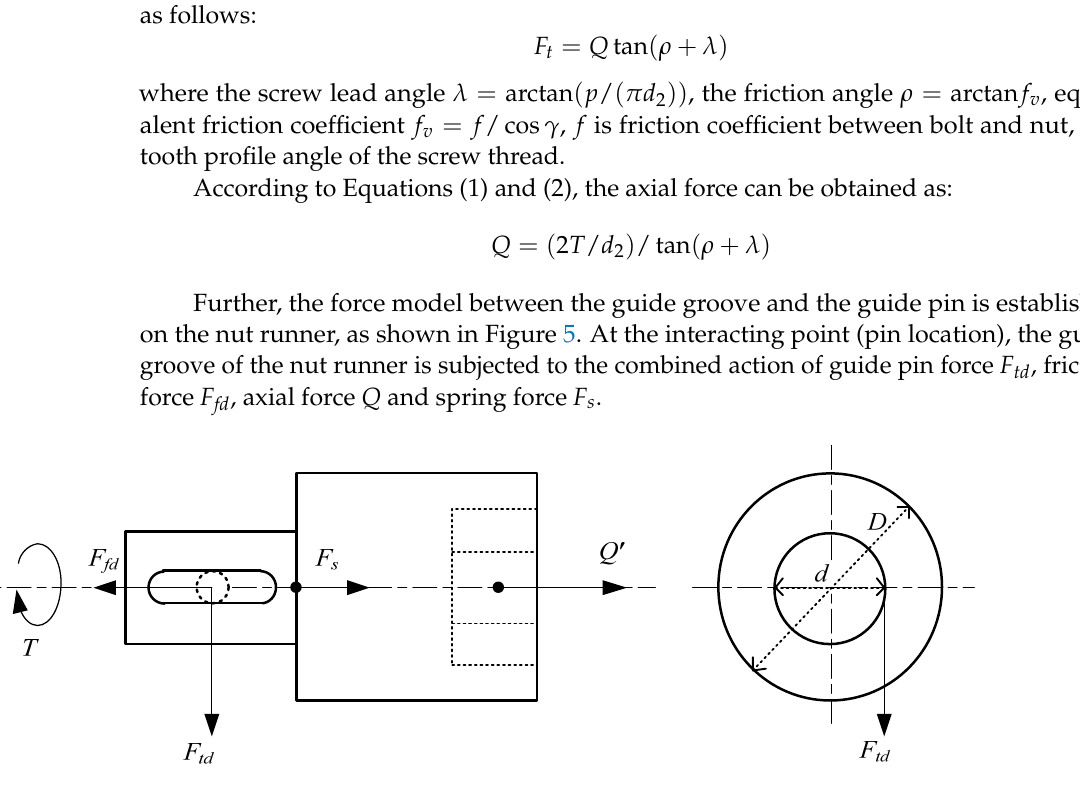
Figure 5. Force state of nut runner.